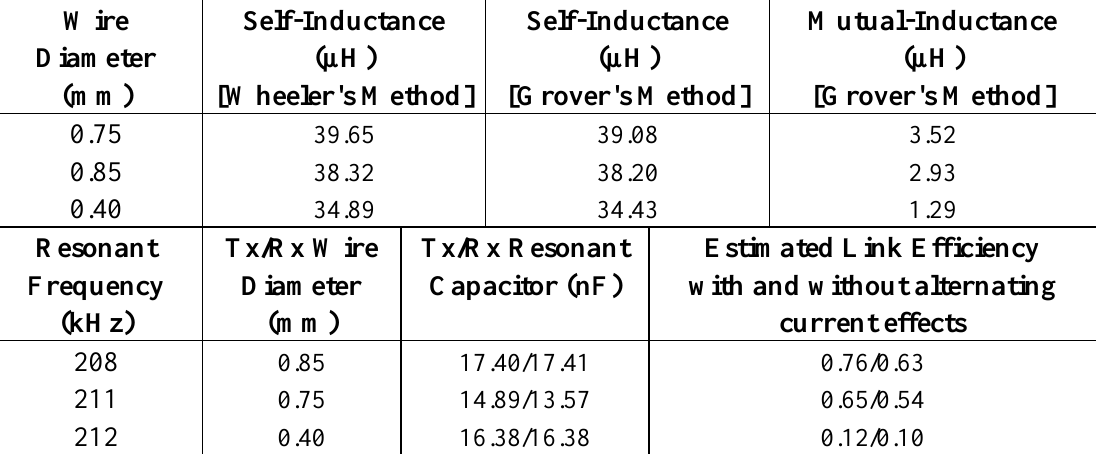
Table 2. Self and mutual inductance values derived using Wheeler’s [26] and Grover’s